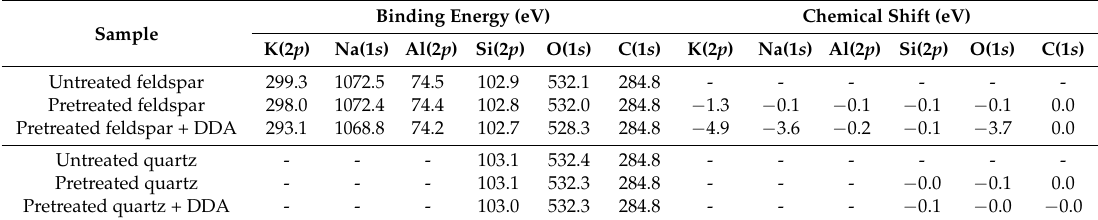
Figure 9. X-ray photoelectron spectroscopy (XPS) spectra of feldspar (A) and quartz (B). Table 1. Binding energy of element on the surfaces of feldspar and quartz untreated and pretreated by 2000 g/t HF in DDA at pH 2.